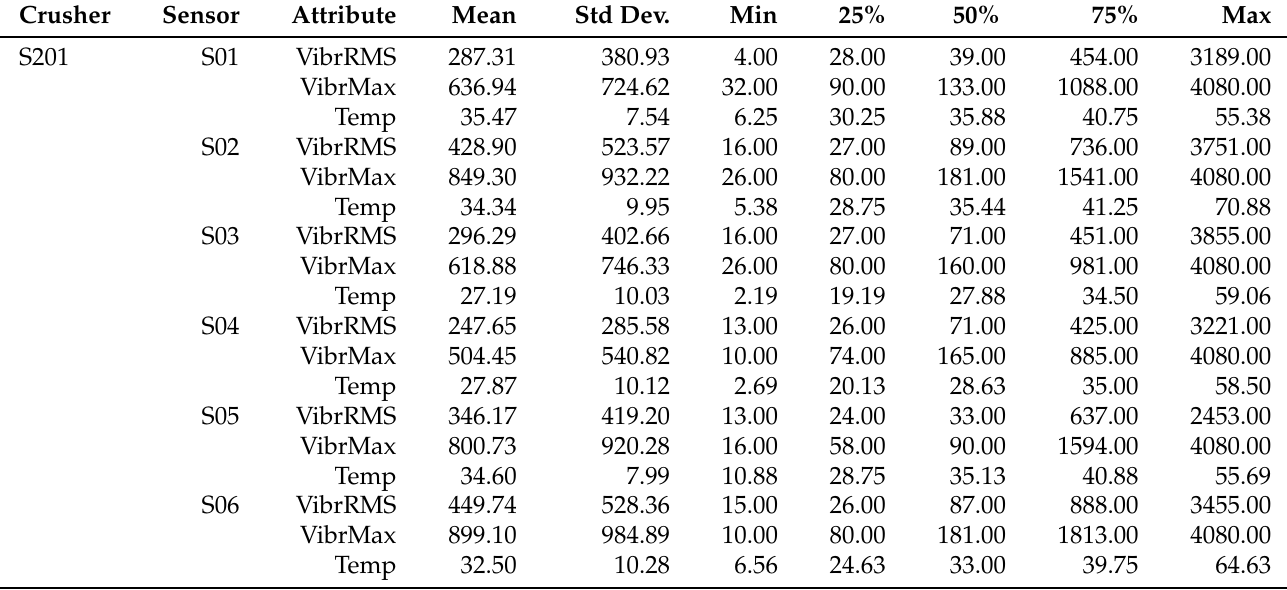
Figure A5. Time series for the S202 gantry collected by six sensors (the red colour indicates the locations of failures). Table A3. Descriptive statistics of each attribute in the gantry data, the statistics include: mean value (mean), standard deviation (std dev.), minimal value (min), 25th percentile (25%), 50th percentile (50%), 75th percentile (75%), and maximal value